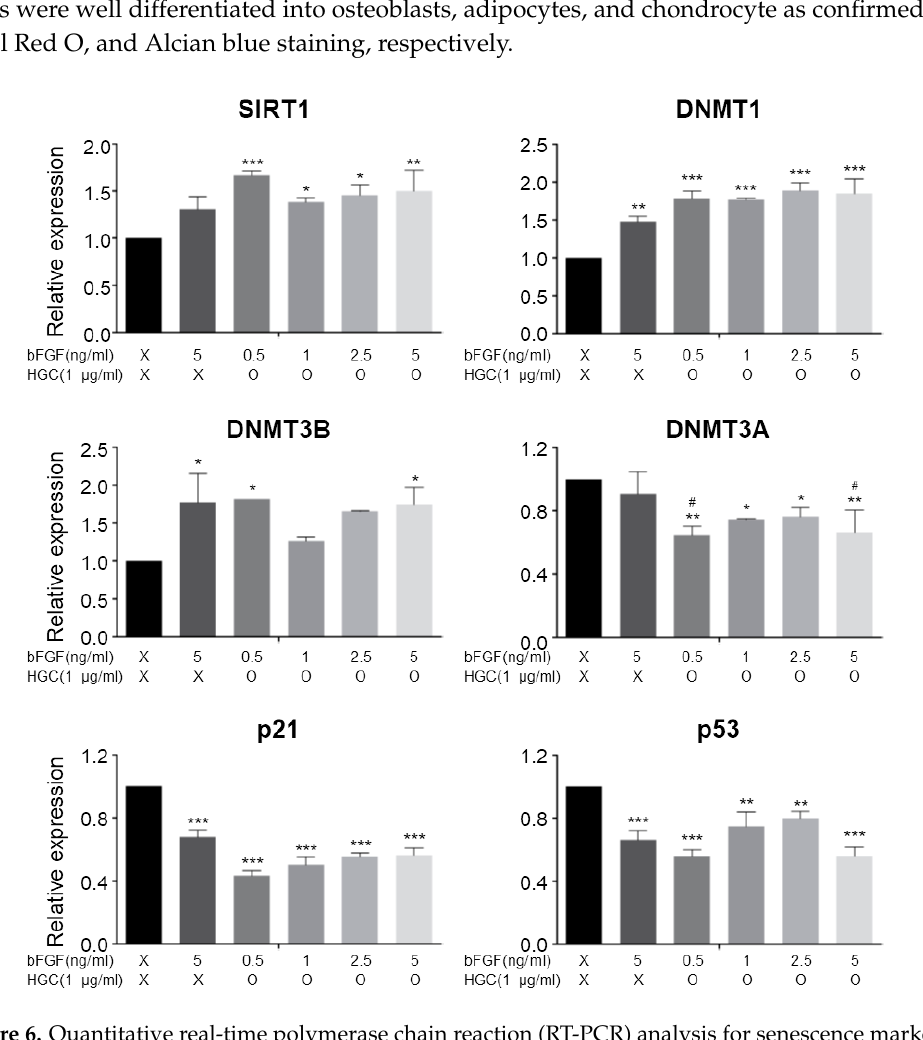
Figure 6. Quantitative real-time polymerase chain reaction (RT-PCR) analysis for senescence markers. * p < 0.05, ** p < 0.01, and *** p < 0.001 relative to the control. # p < 0.05 relative to bFGF-only group.